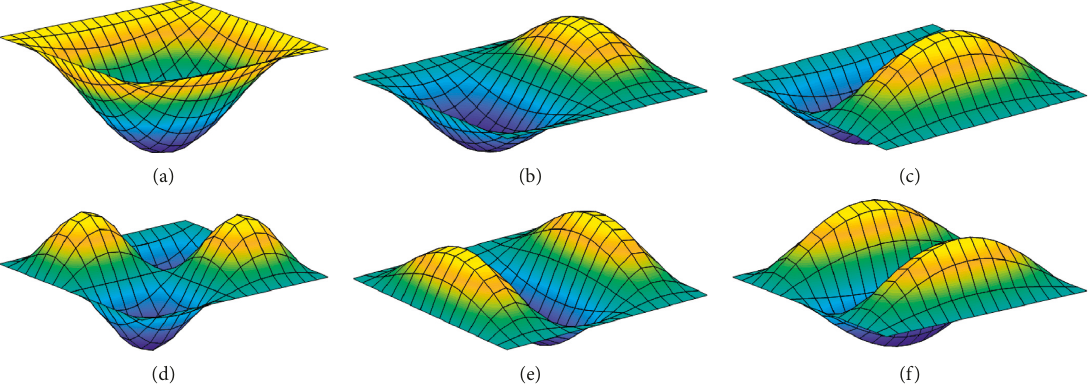
Figure 18: The first six mode shapes of a two-layer square CSCS composite plate. (a) Mode 1. (b) Mode 2. (c) Mode 3. (d) Mode 4. (e) Mode 5. (f) Mode